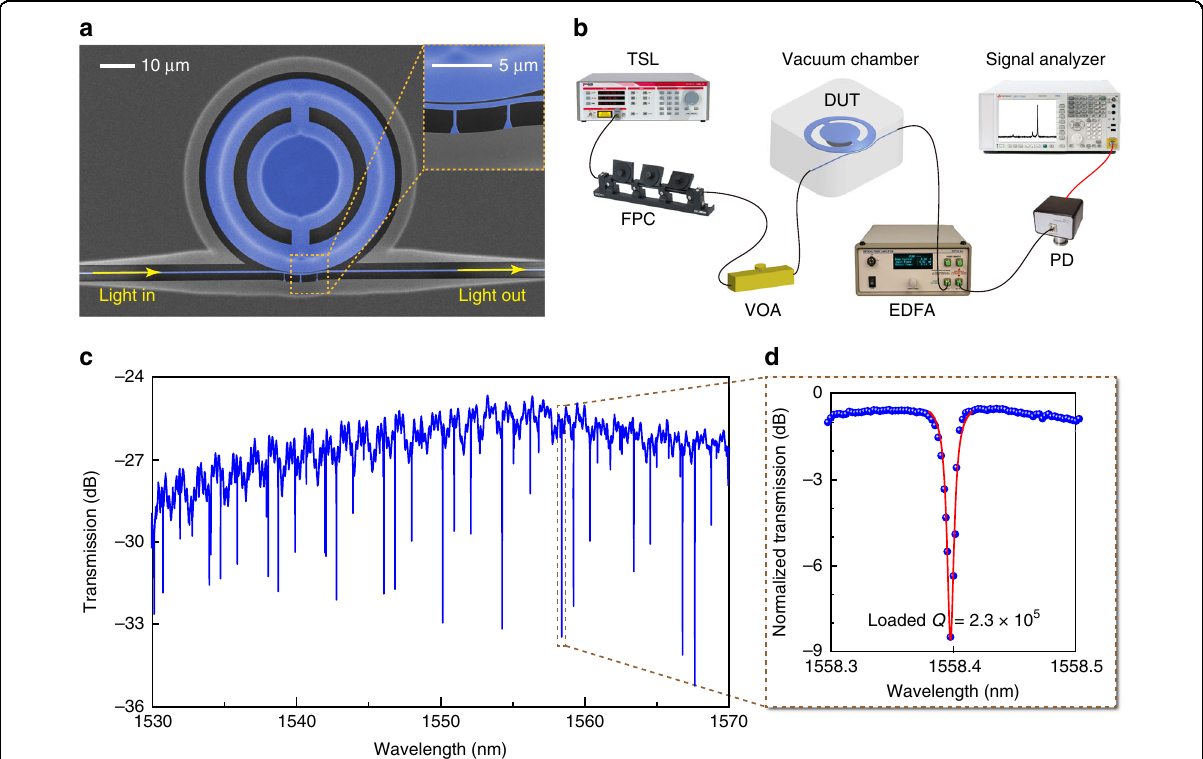
Fig. 3 Device fabrication and experimental characterization. a Scanning electron microscope image of a fabricated silicon optomechanical microresonator. The nearby bus waveguide is used for coupling light into the resonator for optical measurement of its mechanical modes. The inset is a close-up showing the details in the coupling region of the resonator and bus waveguide. b Experimental setup. TSL, tunable semiconductor laser; FPC, fi ber polarization controller; VOA, variable optical attenuator; DUT, device under test; EDFA, erbium-doped fi ber ampli fi er; PD, photodetector. c Measured optical transmission spectrum of the device in ( a ). d Zoomed-in optical transmission spectrum showing an optical resonance with Lorentzian- fi tted optical Q